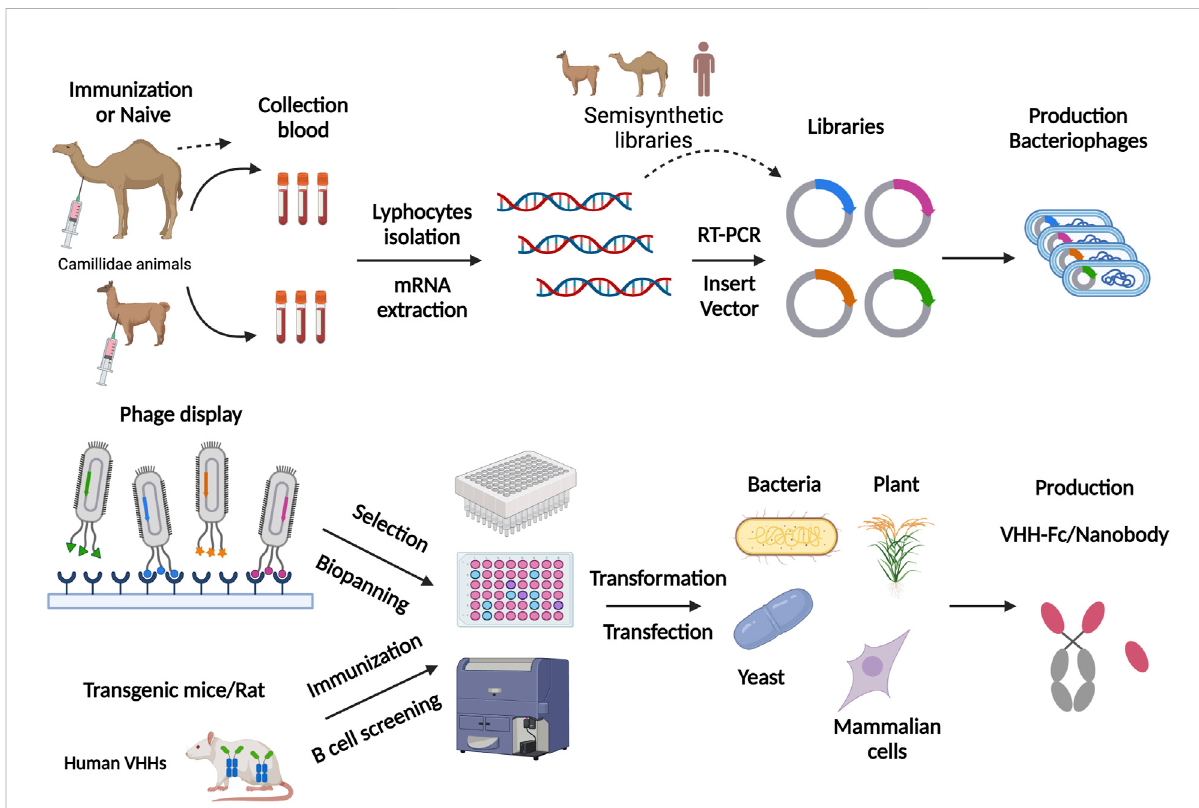
FIGURE 1 Schematicrepresentation ofnanobody productionscheme through phage display library and nanobody transgenic animals.For phage display, this fi gure involves the steps of immunization, library preparation, cloning into the phagemid vector, and transforming into a suitable E. coli strain. Theyaresubsequently panningonthetargetantigen,followedbythewashingandelutionsteps.Fornanobodytransgenic animals,theexperimental stages involved were immunization, direct B cell screening and cloning, followed by in vitro screening. Finally, antigen-speci fi c nanobodies are produced in various expression systems, such as plants, bacteria, yeast and mammalian cells. Figure 1 was created with